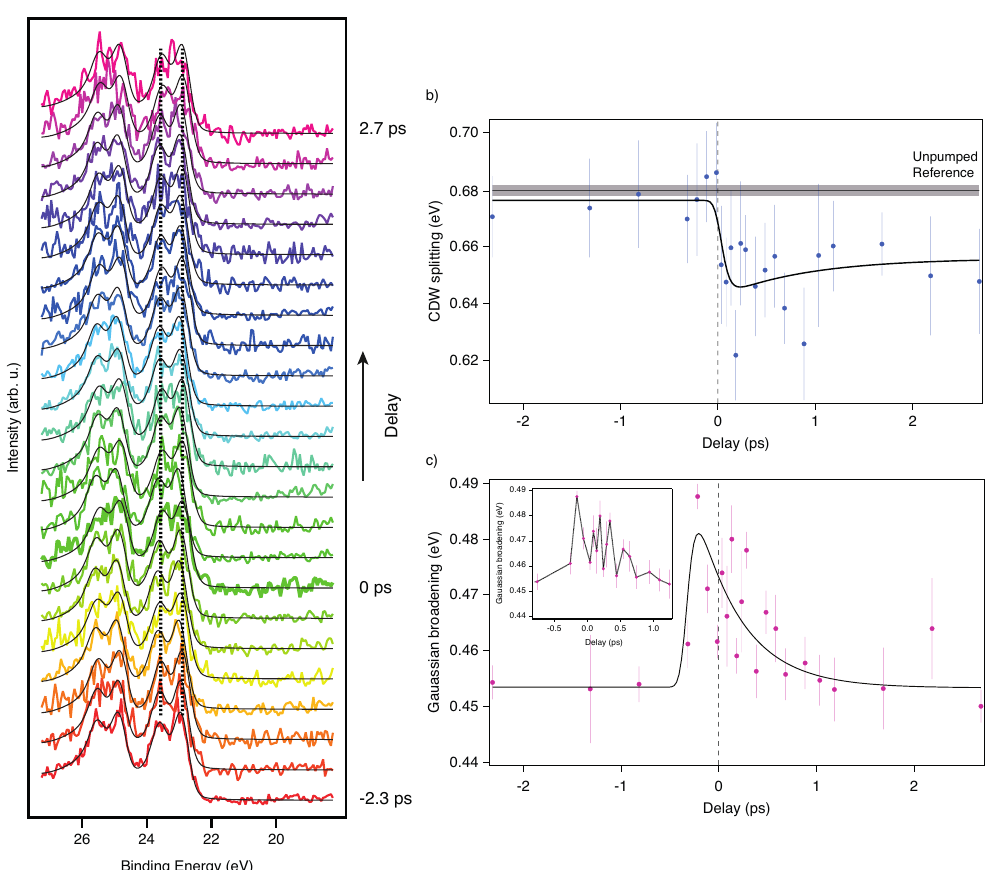
Figure 5. Femtosecond pump-probe XPS Data of TaS 2 . Panel ( a ) shows the photoelectron spectra of the Ta 4f lines acquired with X-ray pulses delivered by the slicing source. The spectrum corresponding to the extracted temporal overlap of the X-ray pulses with the laser pulse is marked with 0 ps. Additionally, the fits to the data are presented (thin black lines). The vertical dashed lines show the peak positions of the reference spectrum. Panel ( b ) shows the dynamics of the CDW splitting and panel ( c ) the dynamics of the Gaussian broadening of the peaks. The inset in panel ( b ) shows the region close to the delay